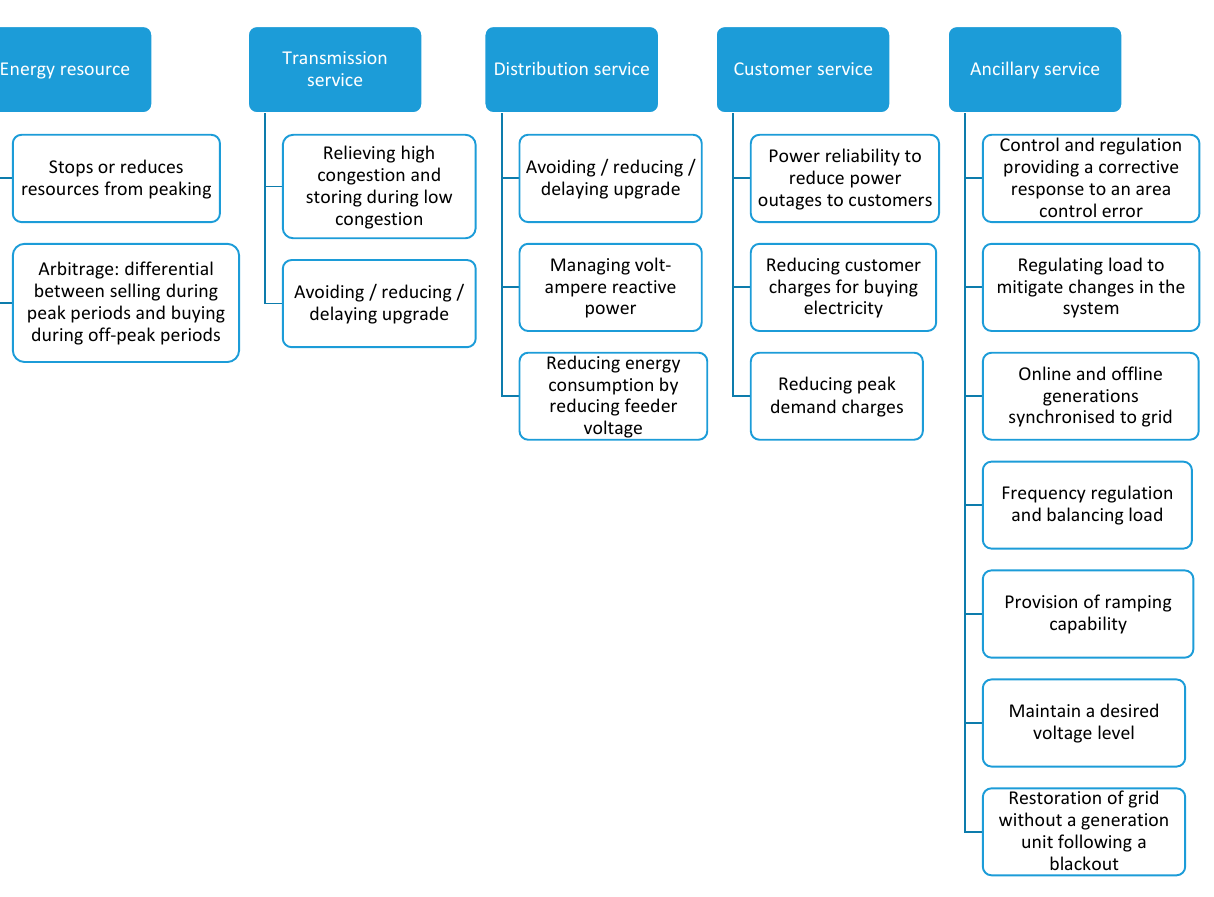
Figure 1. Service provisions of energy storage systems.